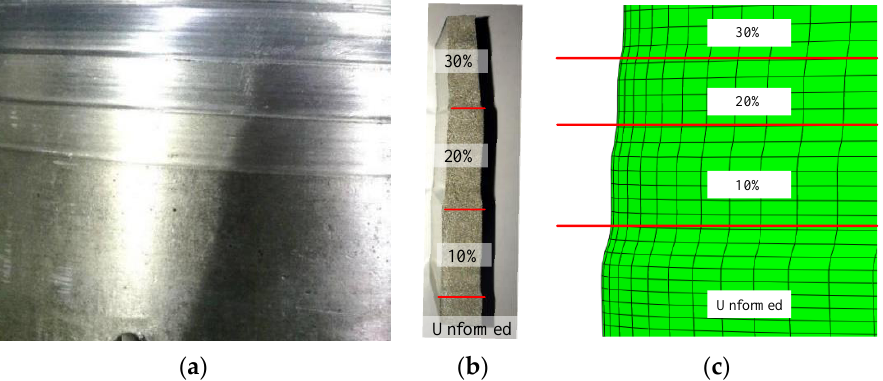
Figure 8. Tube shape with different ACRFF parameters: ( a ) Stage tube of the experiment; ( b ) Section of the stage tube; ( c ) Stage tube of Simulation. Table 1. The shape parameters of the different ACRFF